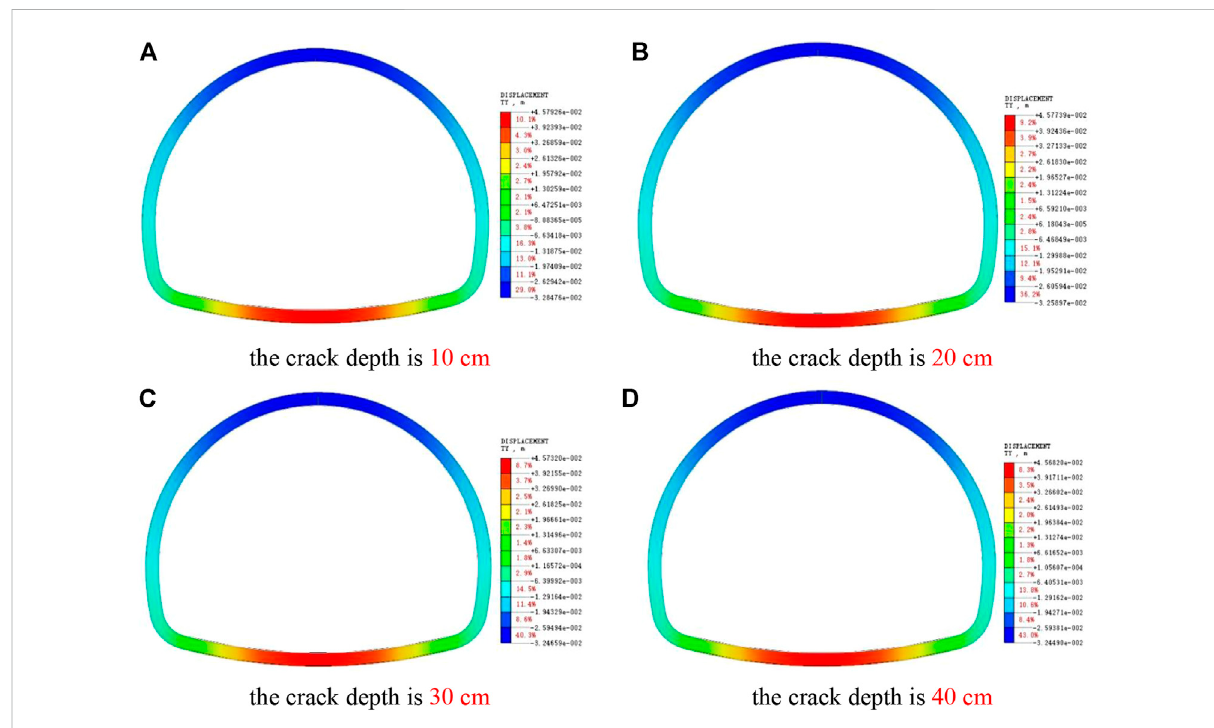
FIGURE 15 Picture ofY-direction displacement of cracked liningatdifferentdepths ofvault. (A) The crack depth is10 cm. (B) The crack depthis 20 cm. (C) The crack depth is 30 cm. (D) The crack depth is 40